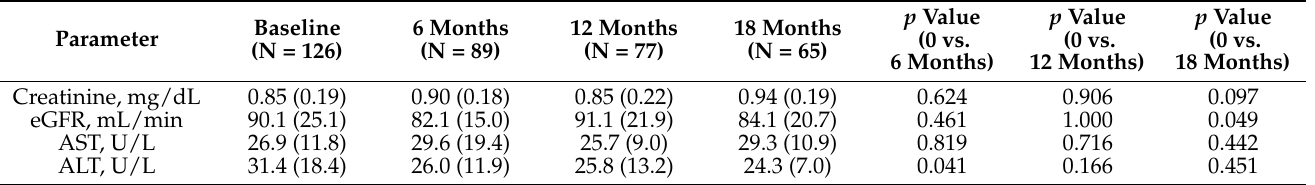
Table 2. Longitudinal comparisons of safety outcome measures for up to 18 months.